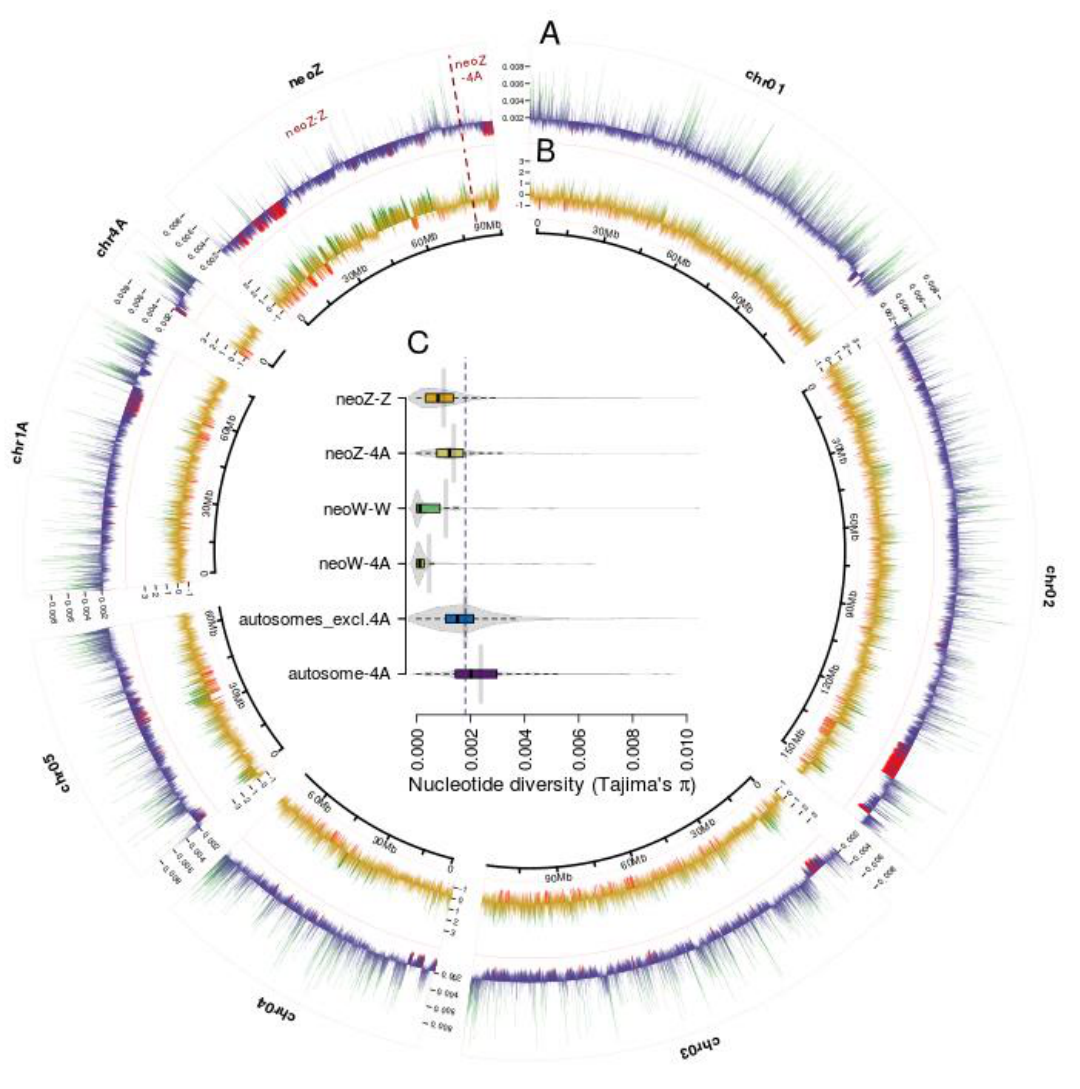
Figure 5. Intra- and inter-chromosomal variations in nucleotide diversity. Variations of Tajima’s π males (A) and D males (B) estimates along the six Z. borbonicus macrochromosomes, the autosomal 4A and the neo-Z chromosome. The two metrics were calculated in non-overlapping 10-Kb sliding windows. Top 2.5% an d bottom 2.5% windows are shown in green and red, respectively. For both Tajima’s π males and Tajima’s D males , each bar shows the deviation from the mean genomic value over the whole genome (Tajima’s π males and Tajima’s D males baselines: 1.82e-3 and -0.26, respectively). C) Interchromosomal differences in Tajima’s π females between autosomes and sex chromosomes. Fig. S5 and S6 show Tajima’s pi and D along most Z. borbonicus